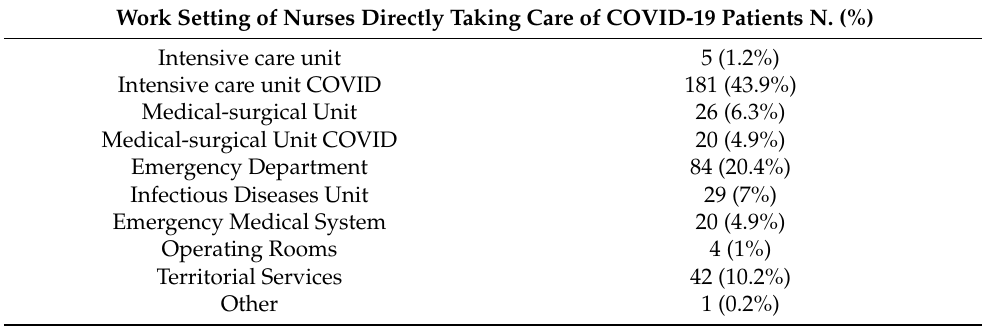
Table 2. Work setting of nurses directly taking care of COVID-19 patients during the pandemic. Work Setting of Nurses Directly Taking Care of COVID-19 Patients N. (%)